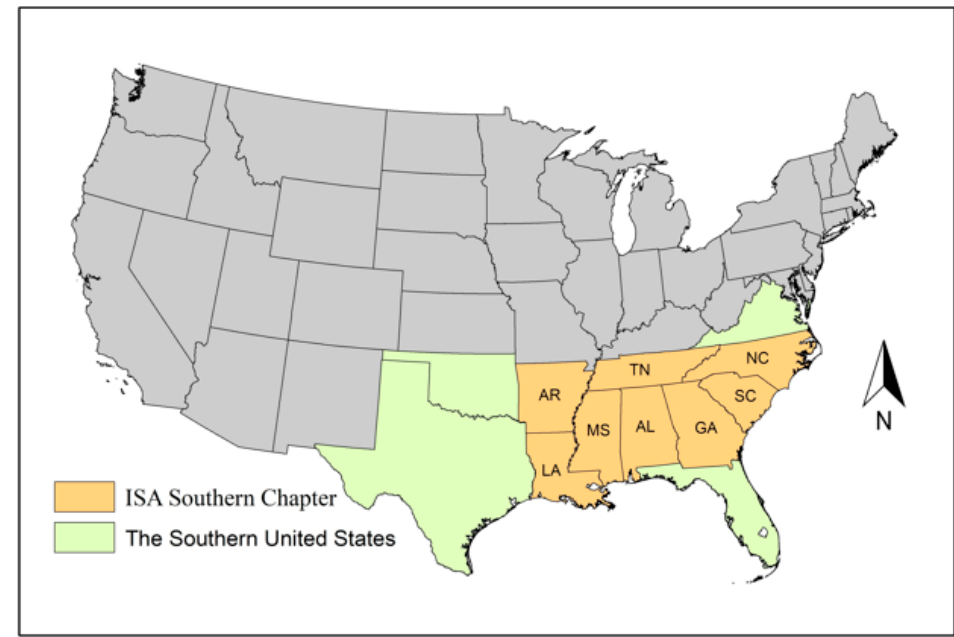
Figure 1. Location of the International Society of Arboriculture Southern Chapter (ISA-SC) in the map of the United